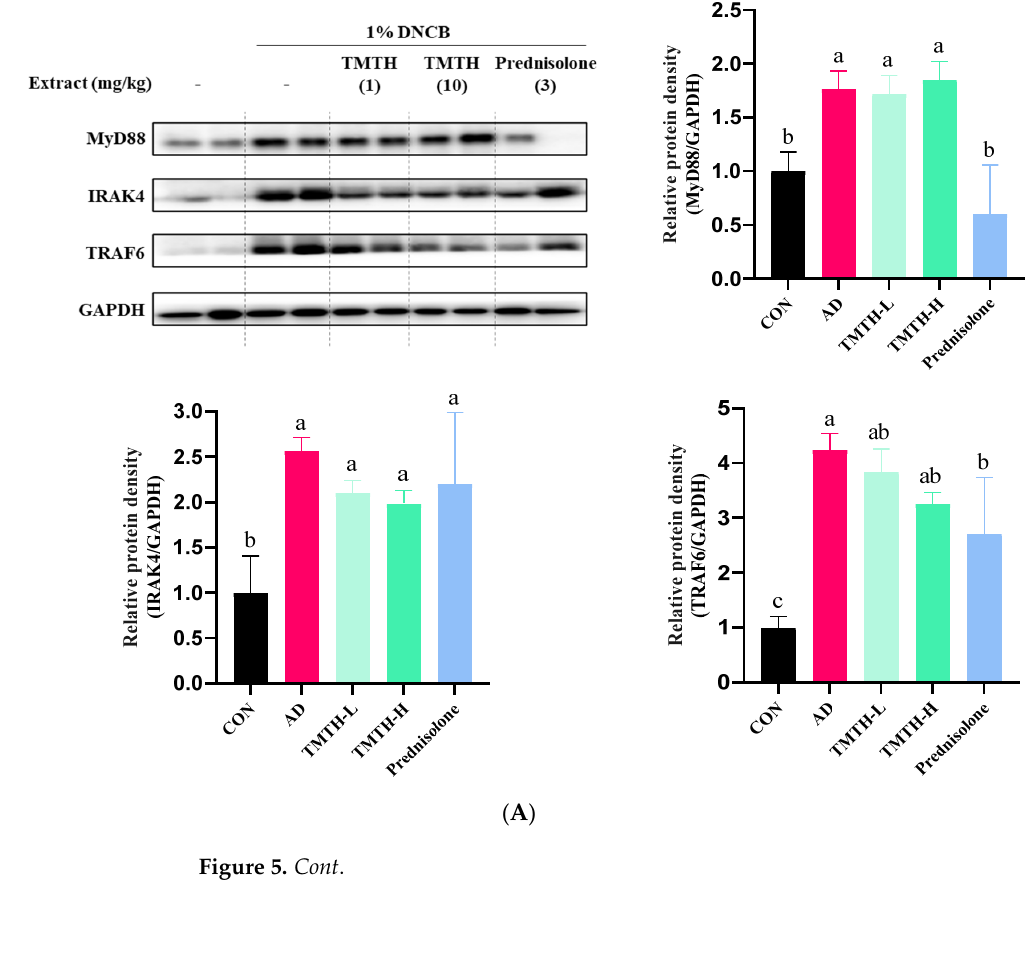
Figure 4. Effects of Tenebrio molitor trypsin hydrolysate (TMTH) on immune organs of 1-chloro-2,4-